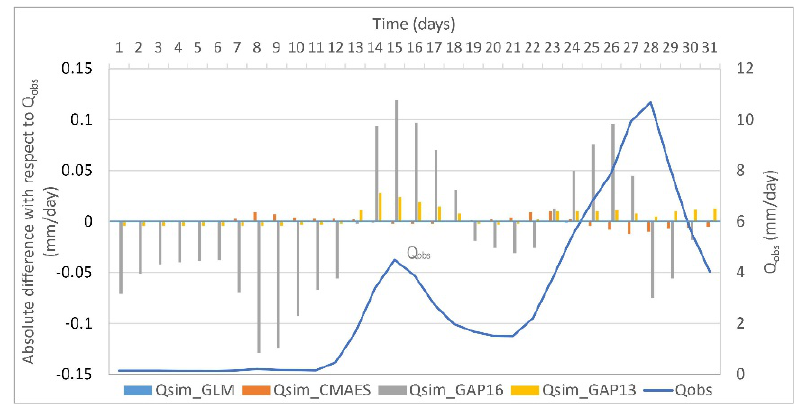
Figure 4. The absolute difference to Q obs for different calibration procedures in the calibration period from 1 March 1985 to 31 March 1985.